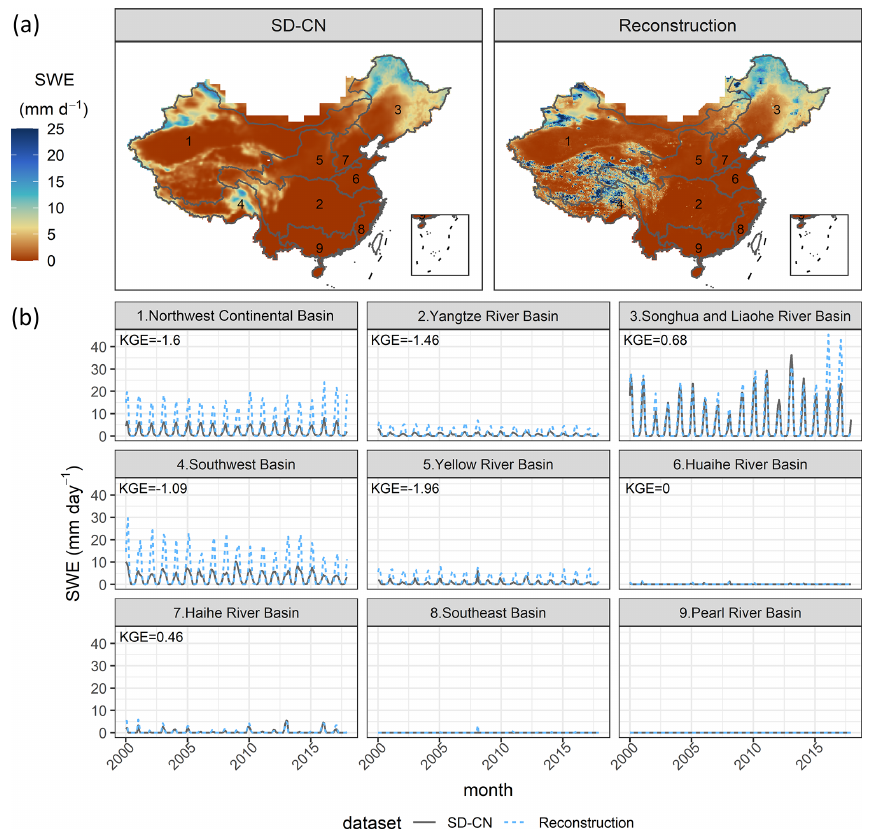
Figure 8. (a) Map of daily average snow water equivalent (SWE) of SD–CN and reconstruction in 2000–2017. (b) Time series of the daily average SWE of SD–CN and reconstruction for nine major river basins in each month of 2000–2017.